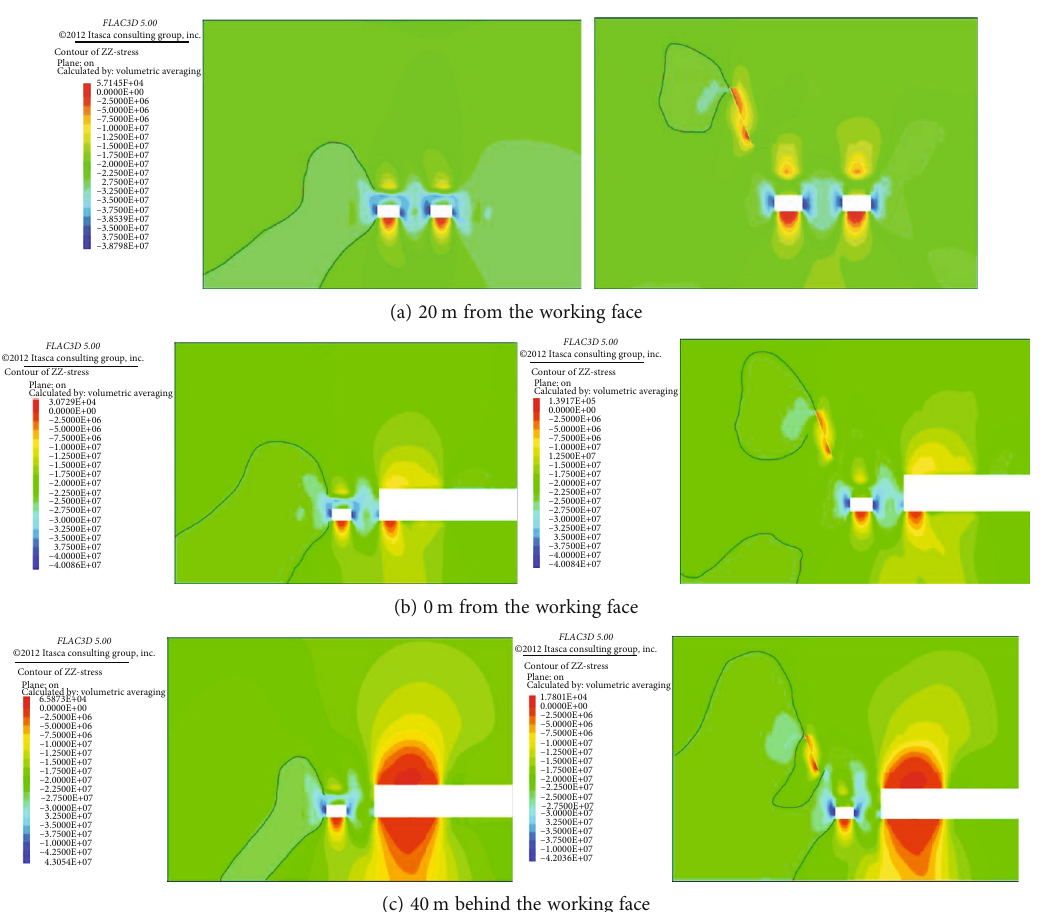
Figure 15: Vertical stress distribution nephogram.